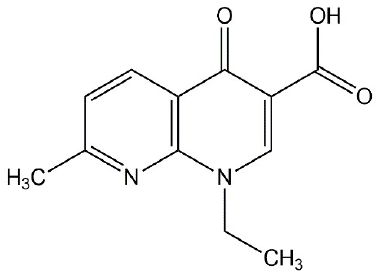
Figure 1. Chemical structure of nalidixic acid.